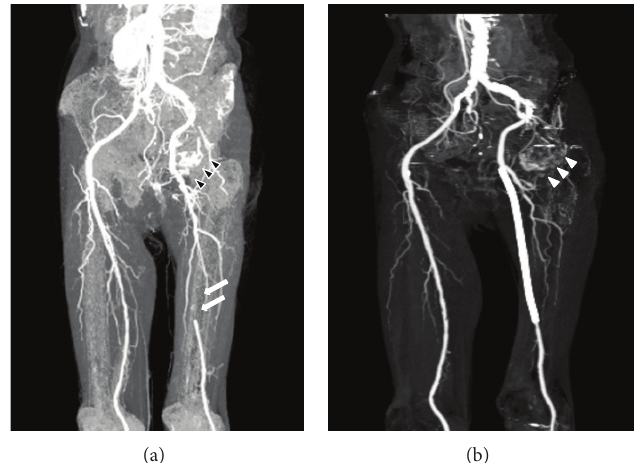
Figure 3: (a) Angiography before PTA taken at another hospital. Complete obstruction of left femoral artery before PTA (white arrow) was observed. Blood stream for left femoral head was alive (black arrow head). (b) Angiography taken just before THA at our hospital. Revascularization of blood vessels (white arrow head) was observed around left hip joint after PTA.